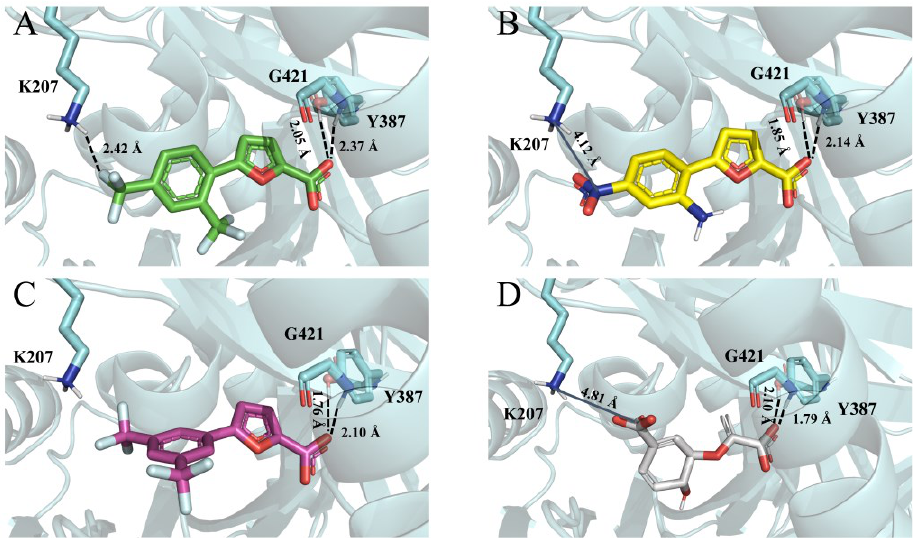
Figure 5. Top-scored docking poses of 1 ( A ), 2 ( B ), 3 ( C ), and chorismate ( D ) within the binding site of the developed Mab -SaS homology model. Ligands and important residues are rendered as sticks, while the protein as cartoon. H-bond and salt-bridge interactions are depicted by a dotted black line and a blue line, respectively. For the sake of clarity, only polar hydrogen atoms are shown. Notice that the fluorine atoms belonging to the trifluoromethyl substituents of 1 and 3 are depicted as cyan sticks.